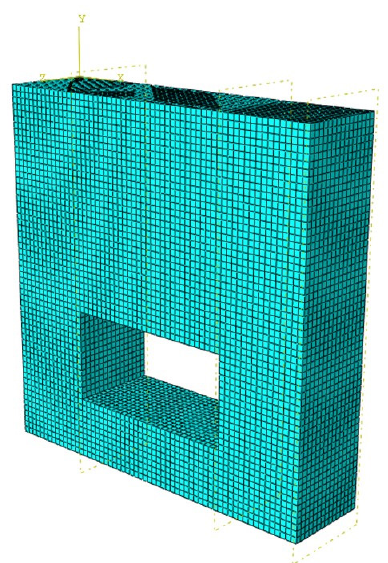
Figure 2 – Computational thermal model (beam with